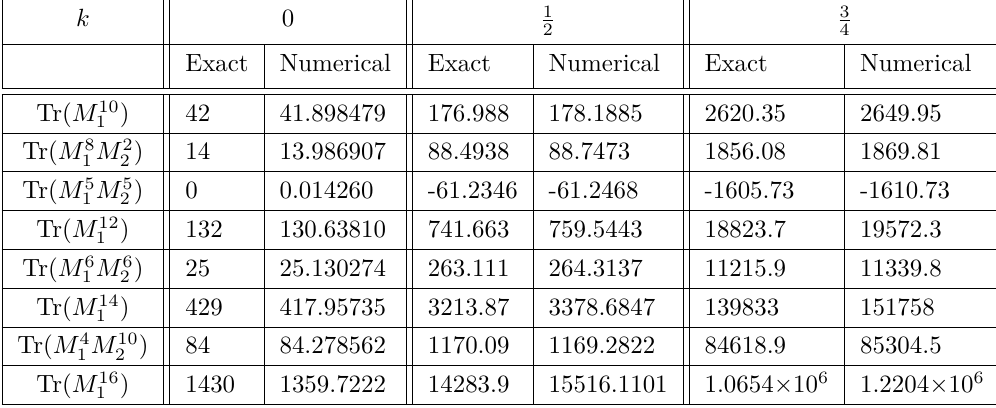
Table 7. Results for g 3 = g 4 = 0 as k is varied. The loops shown have lengths ≥ 10 and ≤ 16